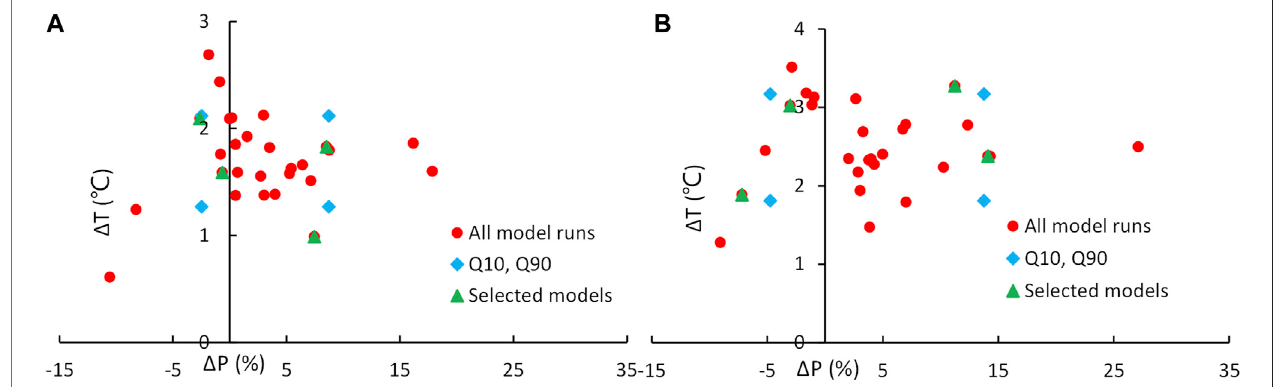
FIGURE2| Model selectioninthisstudyforRCP4.5andRCP8.5. Δ P, Δ Tarethechangeofaverageannualprecipitationandtemperaturein2040 – 2080relativeto the historical period (1961 – 2019) (The selected models in RCP4.5: CMCC-CMS, GFDL-ESM2G, IPSL-CM5A-LR, MPI-ESM-LR; and in RCP8.5: CanESM2, BCC- CSM1.1m, MIROC-ESM,